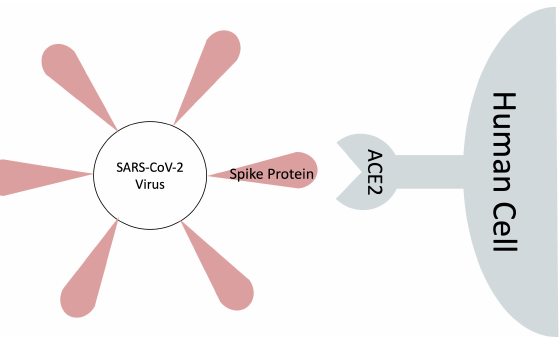
Figure 1. Binding scheme of the SARS-CoV-2 spike protein to the human ACE2 receptor.